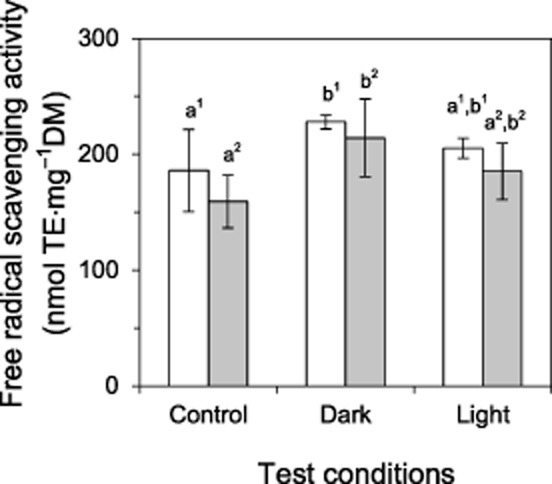
Free radical scavenging activity following controlled sublethal heat stress. Free radical scavenging activity in Senecio incanus (white bars) and Ranunculus glacialis (grey bars), expressed as trolox equivalents per mg dry mass (nmol TE·mg−1DM; means ± SD) immediately after the termination of an in situ heat stress treatment (S. incanus: 44 °C, R. glacialis: 41 °C) in the dark and light mode is shown relative to untreated plants (control). Significant differences between species (superscript numbers) are indicated by different letters (one-way anova, Duncan's test, P < 0.05).